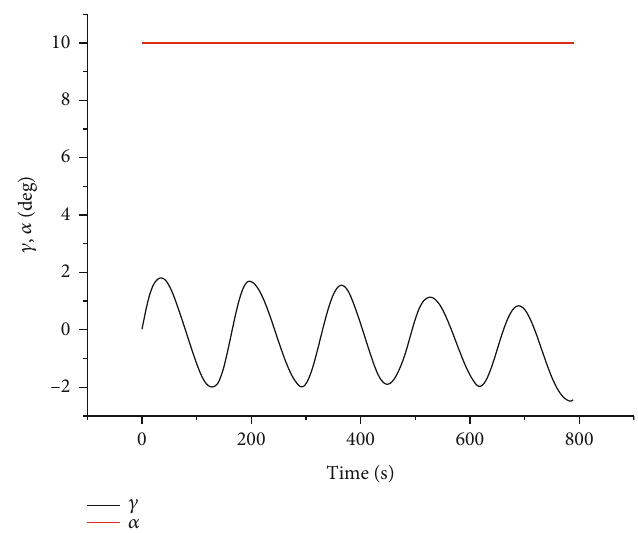
Figure 5: Elevation angle with constant optimal angle of